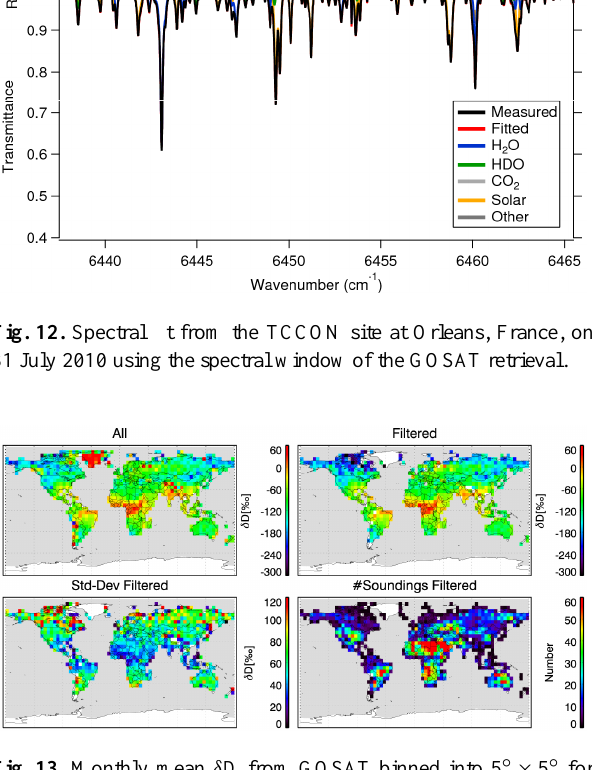
Fig. 13. Monthly mean δ D from GOSAT binned into 5 ◦ × 5 ◦ for the cloud-free retrievals (left top panel) and the cloud-free, quality- filtered retrievals (top right panel) for June 2009. The bottom panels give the standard deviation and the number of soundings for the quality-filtered retrievals.